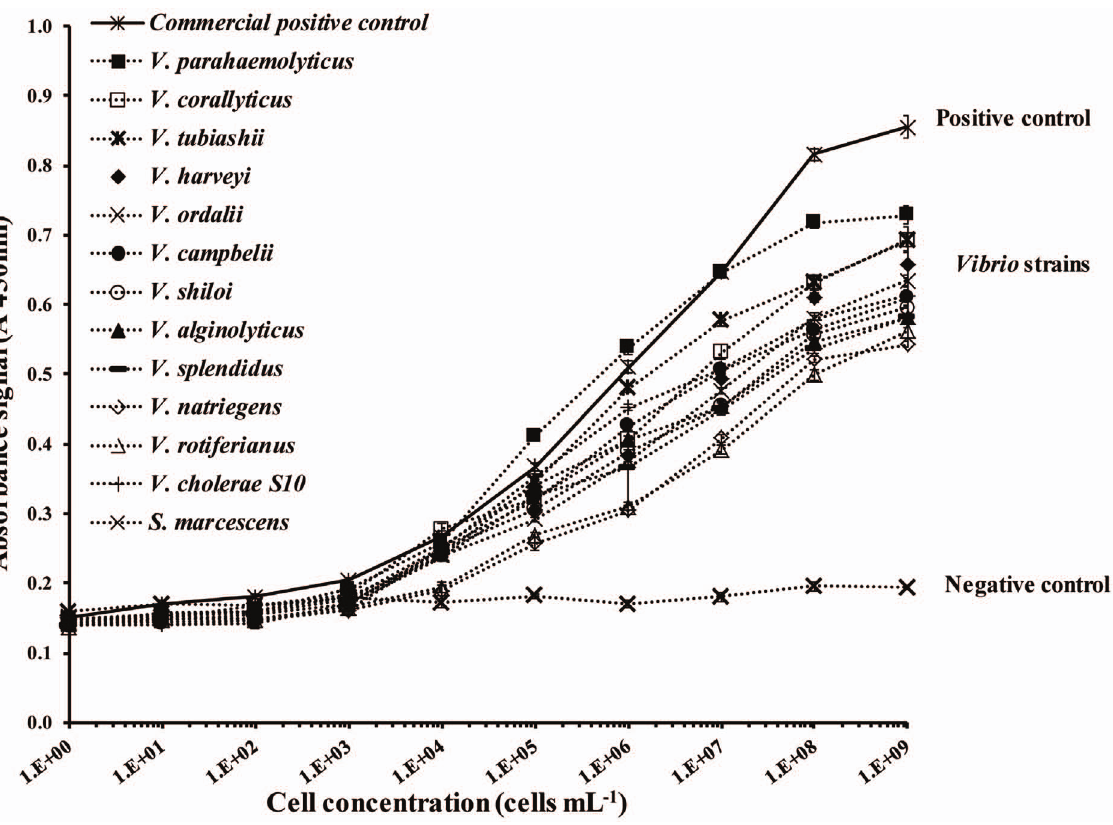
Figure 3. Affinity of the different Vibrio strains and commercial positive control to the functionalised surface using optimised conditions. Absorbance signals obtained after a 30 min cell capture step on the functionalised surface and a 30 min detection step using a 1/1000 dilution of horseradish peroxidase anti- Vibrio antibody (HRP- a Vib Pab).